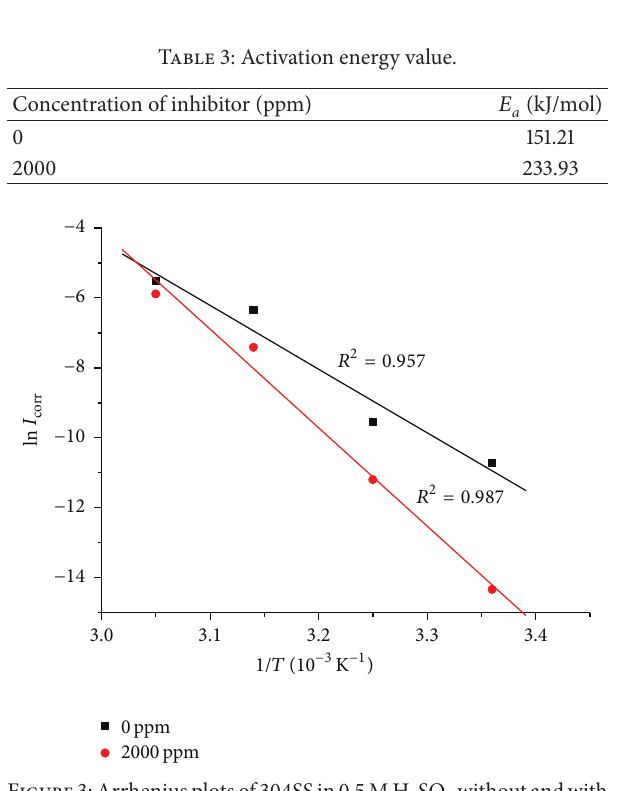
Arrhenius equation